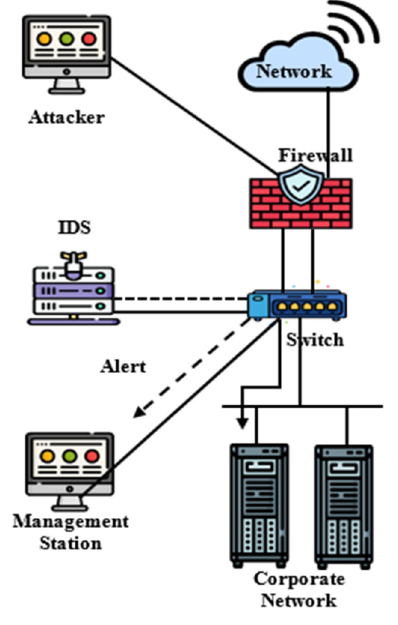
Figure 4. The general structure of the network and IDS.